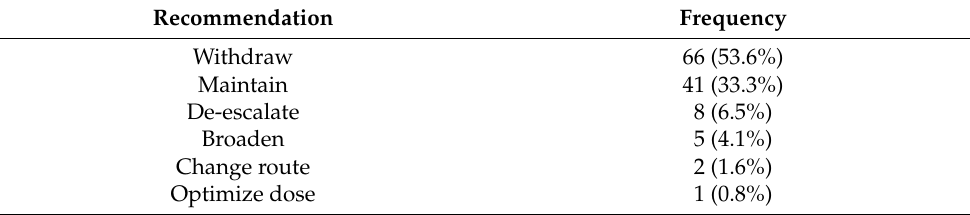
Table 1. List of recommendations issued during the stewardship